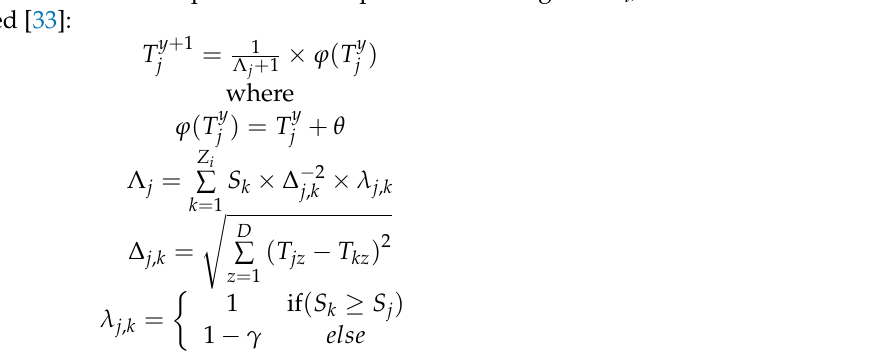
or crowdedness, which computes the effect of the neighbors on T j . D shows the number of variables of trees. The function ϕ ( . ) calculates the growth T j in the same environment when its neighbors are ignored. S k indicates the strength/fitness of the k th neighbor tree, ∆ Λ j and the k th neighbor, the variable λ j , k is the impact of the j , k is the distance between neighbor T k on the growth of the tree T j . γ ∈ [ 0, 1 ] is a random asymmetry index, which shows the value to which the effect of a relatively weak neighbor is